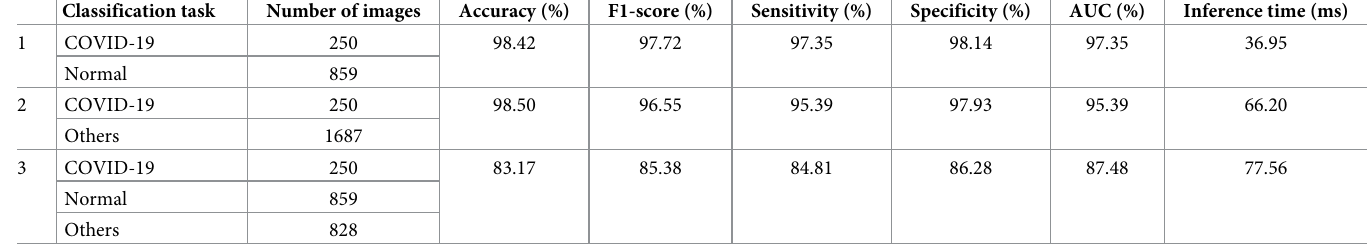
Table 3. Results of classifying COVID-19 patients with other groups. Three classification tasks were completed in order to determine whether ECG signals might be used to diagnose COVID-19. Classification